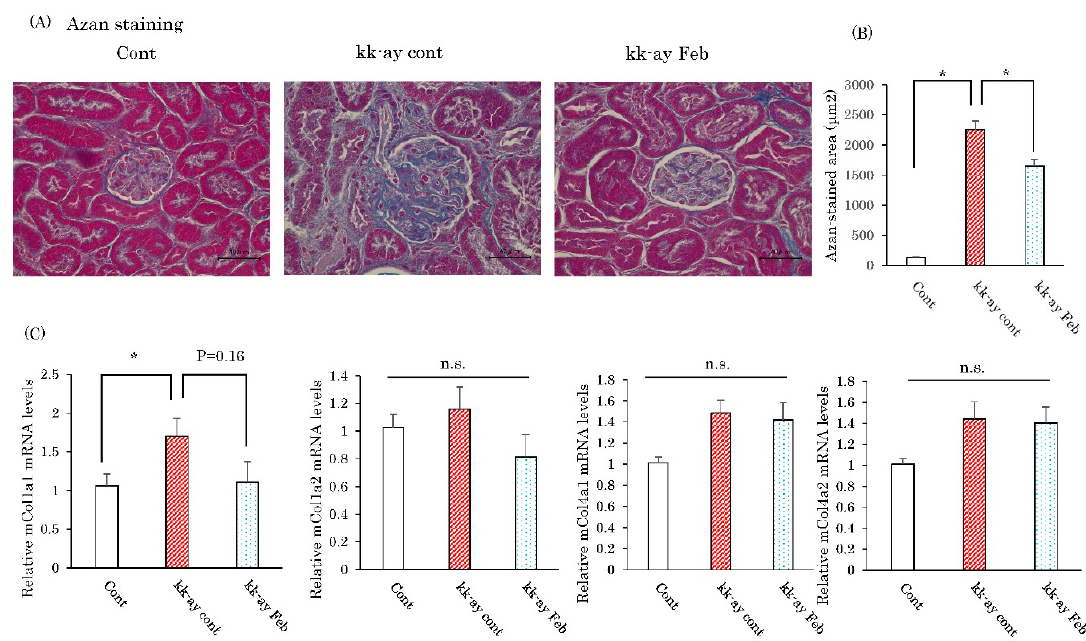
Figure 4. Febuxostat prevented progression of kidney fibrosis. ( A ) Azan staining of kidney fractions. Scale bar = 40 µ m. ( B ) Relative mRNA levels of fibrotic markers in the kidneys. ( C ) The renal fibrotic area was assessed using Azan staining and then measured using image J. Data are means ± SE. * p < 0.05. n = 8 for control group, n = 10 for KK-Ay mice without febuxostat group and n = 8 for KK-Ay mice with febuxostat group.